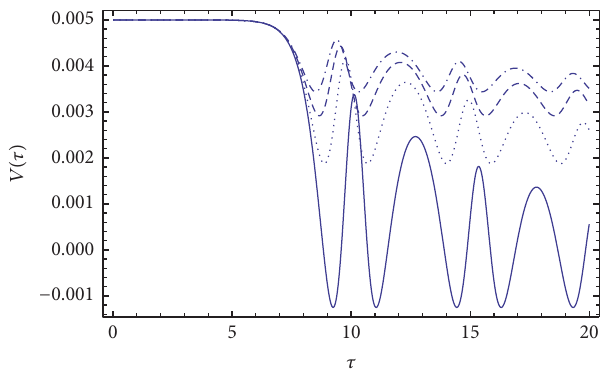
Figure 7: Variation of the Higgs type potential of the scalar field as a function of the dimensionless time 𝜏 for different values of the parameter 𝜂 : 𝜂 = 10 (solid curve), 𝜂 = 20 (dotted curve), 𝜂 = 30 (dashed curve), and 𝜂 = 40 (dashed dotted